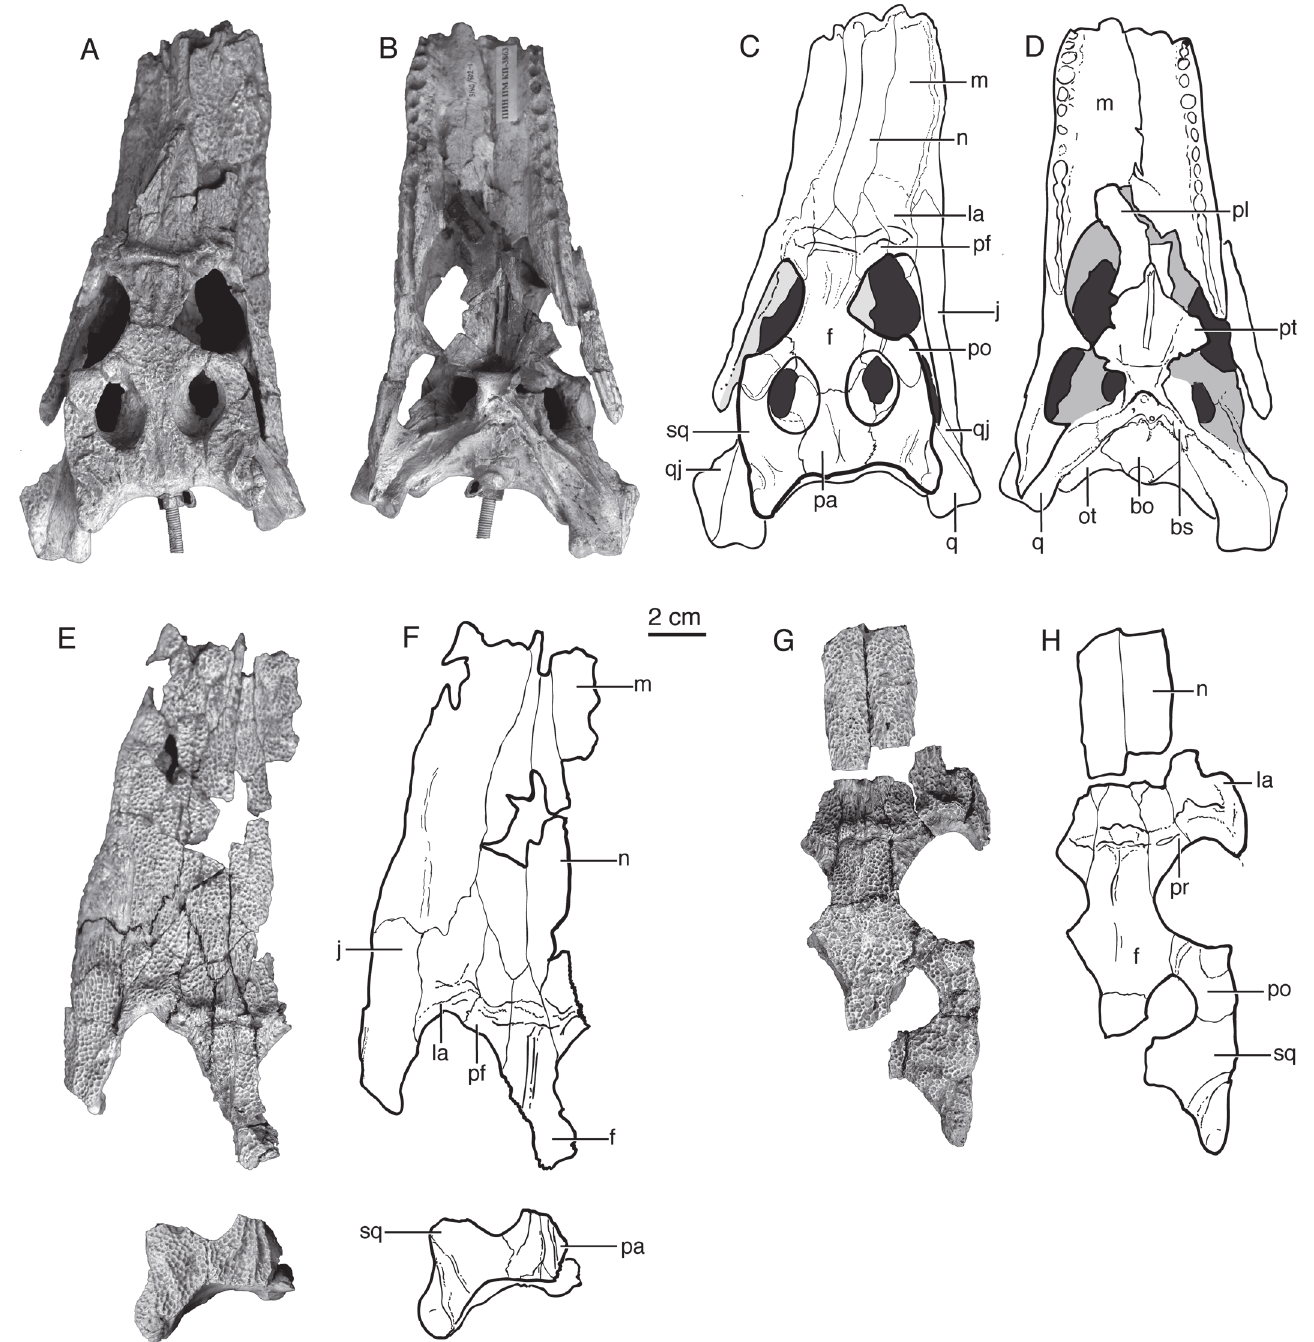
Fig 8. Paralligatorids from Nemegt Fm, Maastrichtian. A , Shamosuchus ulanicus (= Paralligator gradilifrons ) (PIN 3140-502), dorsal view; B , PIN 3140- 502, ventral view; C , line drawing of PIN 3140-502, dorsal view; D , line drawing of PIN 3140-502, ventral view; E , S . tersus (= Paralligator gradilifrons ) (PIN 3141-501), dorsal view; F , line drawing of PIN 554-1, dorsal view; G , S . ancestralis (= Paralligator gradilifrons ) (PIN 551-29/1), dorsal view; H , line drawing of PIN 551-29/1, dorsal view. Abbreviations: bo, basioccipital; bs, basisphenoid; d, dentary; f, frontal; j, jugal; la, lacrimal; m, maxilla; n, nasal; ot, otoccipital; pa, parietal; pf, prefrontal; pl, palatine; pm, premaxilla; po, postorbital; pt, pterygoid; q, quadrate; qj, quadratojugal; sq, squamosal.